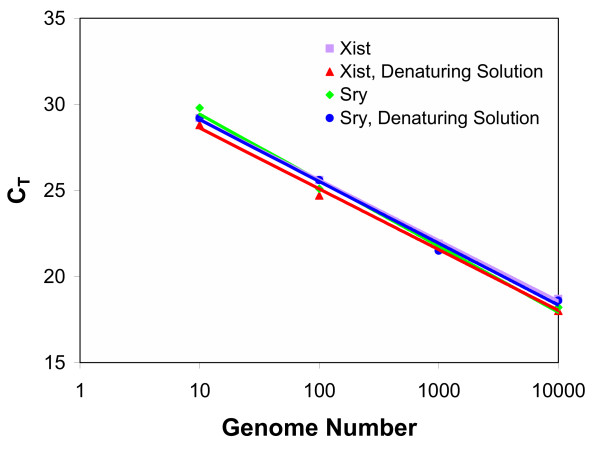
Xist/Sry real-time PCR efficiency in the presence or absence of diluted denaturant. Standard curve used for the quantification of multiplexed Xist and Sry amplicons, obtained by serial dilution of male mouse genomic DNA at known copy number (abscissa). The Xist (light purple) and Sry (green) signals had very similar CT values (ordinate) at every DNA concentration tested, because the two PCR reactions had been optimized to be equally efficient. The addition of denaturing solution at the concentration used in the PurAmp assays did not inhibit PCR (red, Xist; blue, Sry), as also seen in the case of the hsp70i amplicon.